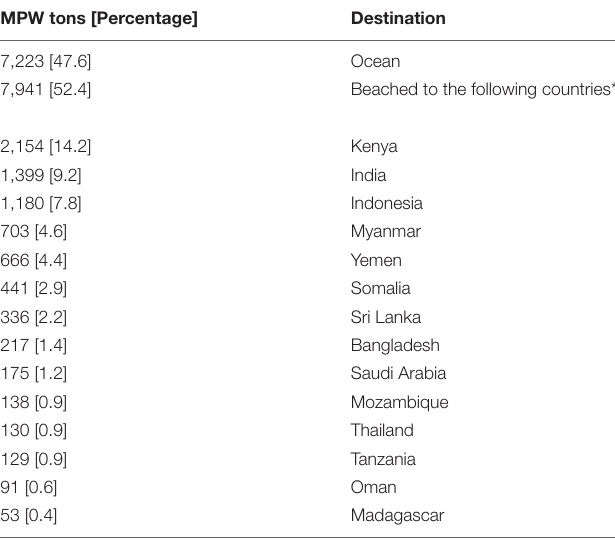
TABLE 1 | Destination of the modeled MPW that are released from Kenya at the end of the 2010 − 2019